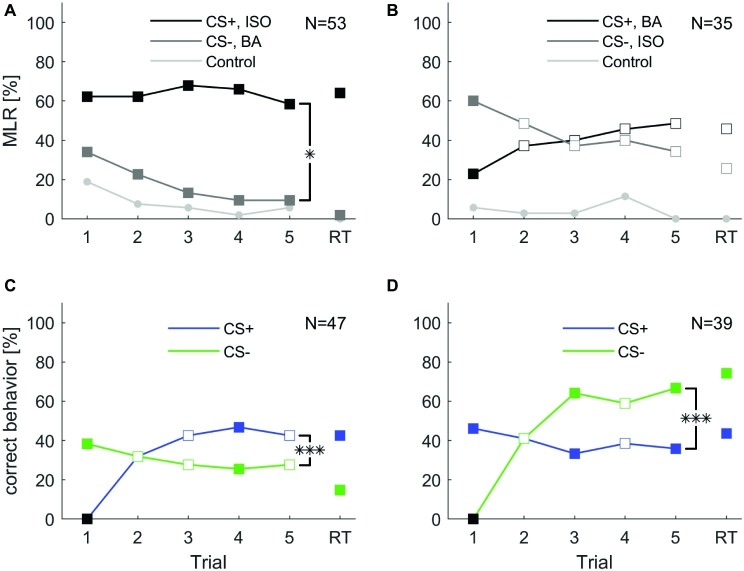
Classical olfactory conditioning over five trials with a memory retention test after 10 min. Filled squares indicate trials in which a significant difference was found between CS+ and CS− (χ2 test). Asterisks indicate that responses changed for the conditioned stimuli (CS+ and CS−) over trials (two-way ANOVA, repeated measures: treatment × trial interaction *: p < 0.05; ***: p < 0.001). (A) When isoamyl acetate (ISO) was the rewarded odor (CS+, black), the average group response did not increase during training. Responses to the punished odor BA (CS−, dark gray) decreased significantly over trials (one-way ANOVA: p = 0.002) and odor × trial interaction was significant (two-way repeated measures ANOVA: p = 0.02). (B) When BA was rewarded (CS+, black), responses increased considerably, however not significantly (one-way ANOVA: p = 0.208). Responses to ISO decreased, but again, not significantly (one-way ANOVA: p = 0.189). The odor × trial interaction was not significant (two-way repeated measures ANOVA: p = 0.113). (C) When excluding all spontaneous responding animals to the rewarded odor, response to CS+ increased significantly (one-way ANOVA: p < 0.001). Responses to the CS− decreased over trials, but not significantly (one-way ANOVA: p = 0.686). The treatment × trial interaction was significant (two-way repeated measures ANOVA: p < 0.001). (D) When excluding all not spontaneous responding animals to the punished odor the number of animals that behaved correctly to CS− over trials increased significantly (one-way ANOVA: p < 0.001), while response to CS+ did not change significantly over trials (one-way ANOVA: p = 0.814). The treatment × trial interaction was significant (two-way repeated measures ANOVA: p < 0.001). Black squares in (C,D) indicate the exclusion of animals that did not behave correctly in the first trial.